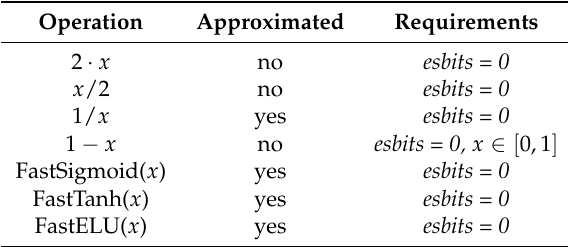
Table 1. Most interesting L1 operators implemented in cppPosit and their requirements to be applied on the argument x